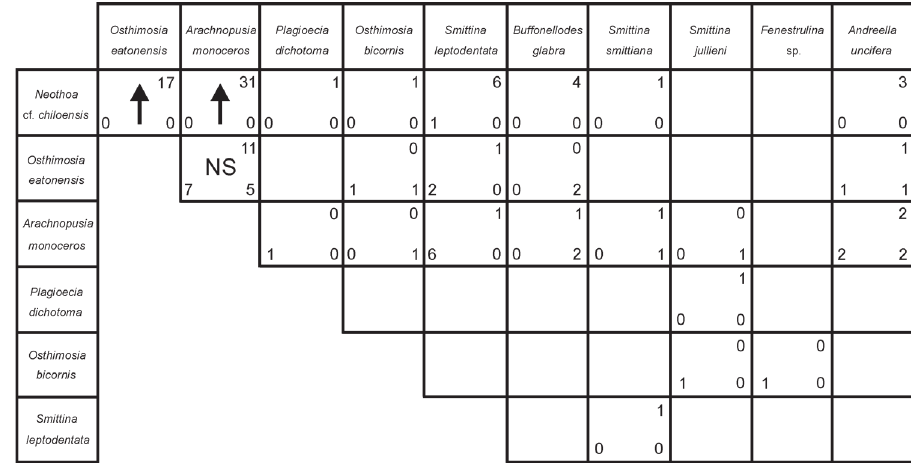
Fig. 7. – Matrix of competitive interactions among 11 encrusting bryozoan species. The figures in the top right corner and in the bottom left corner of each box are the numbers of wins and losses of the species shown above respectively. The figure in the bottom right corner is the number of ties recorded between the 2 interacting species. An arrow points out the significant winner in a chi-square test. NS: P>0.05. Only interactions involving more than 10 encounters were statistically